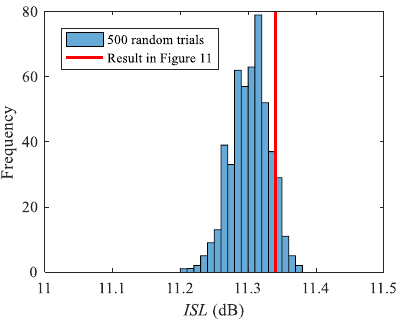
Figure 16. Histogram of the ISL values obtained over 500 random trials when the parameters are M = 4, N = 64, and K = 4.